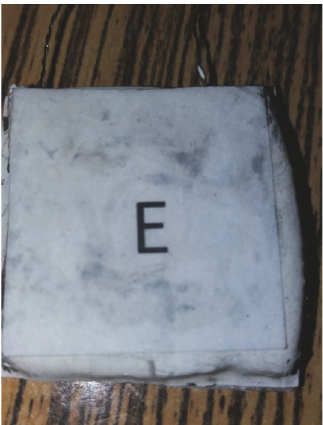
Figure 4: Image of the hMRE (E). Dimensions are the same as in Figure 1.